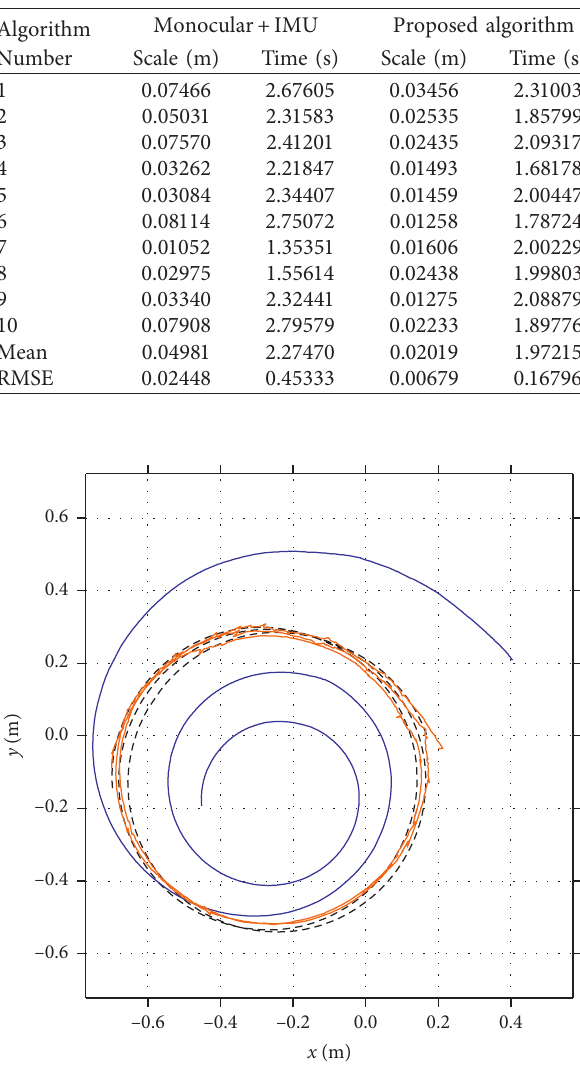
Table 1: Scale values and convergence time.